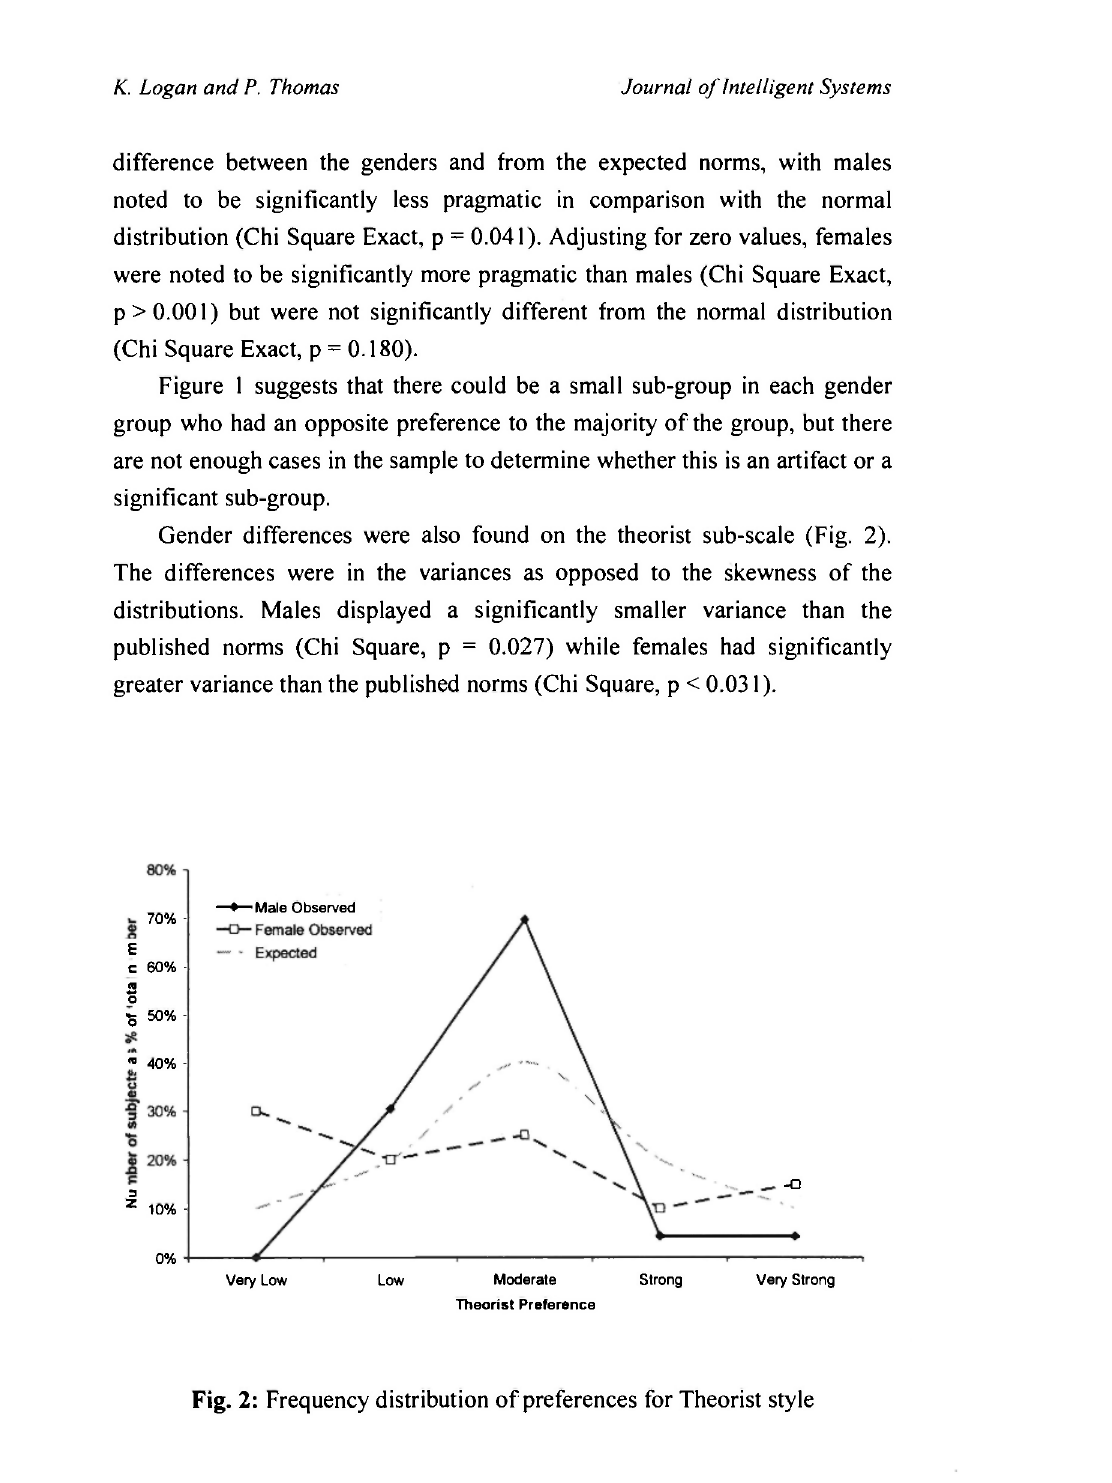
Fig. 2: Frequency distribution of preferences for Theorist